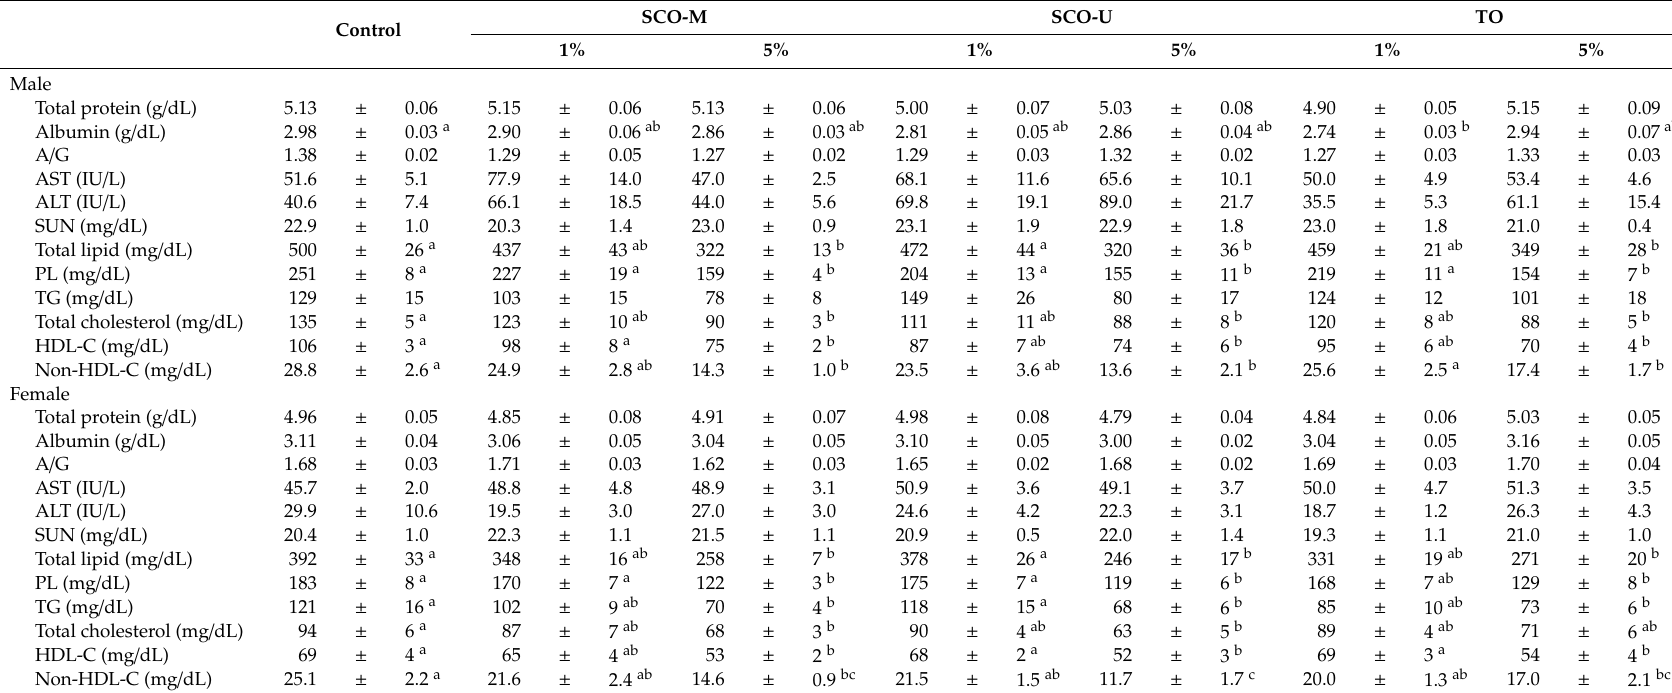
Table 2. Serum biochemical parameters of mice administered scallop oil (SCO) for 28